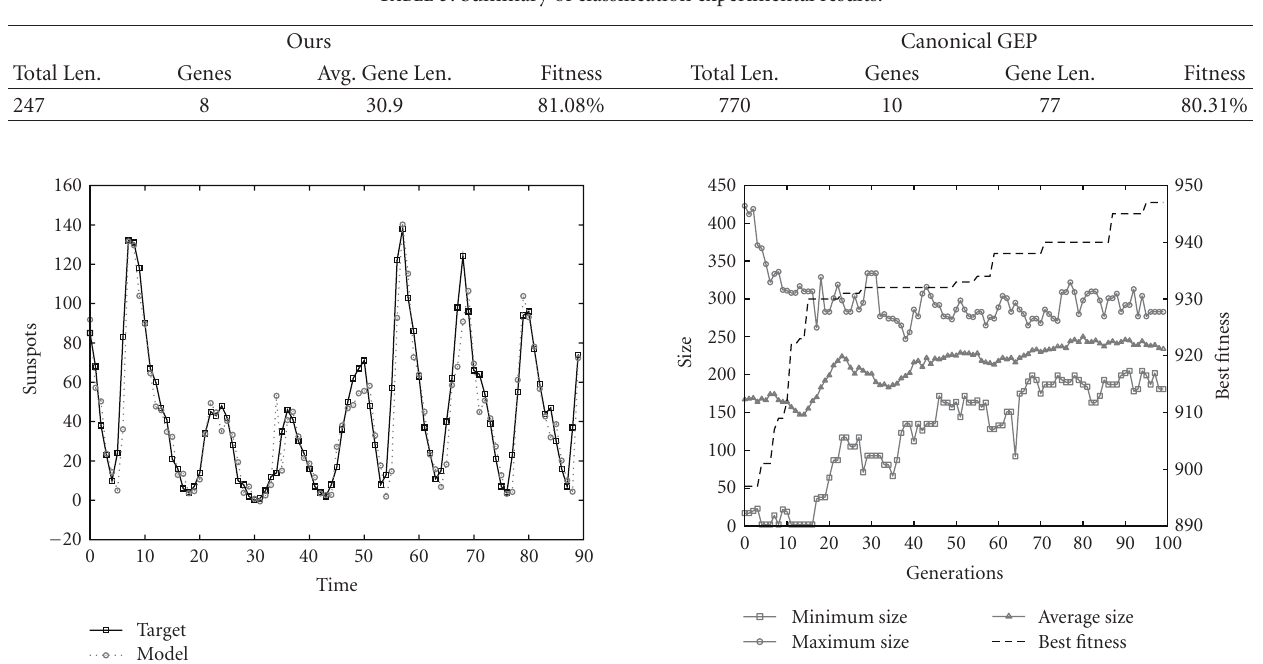
Figure 13: LiveDescribe experiment: chromosome sizes and best fitness.